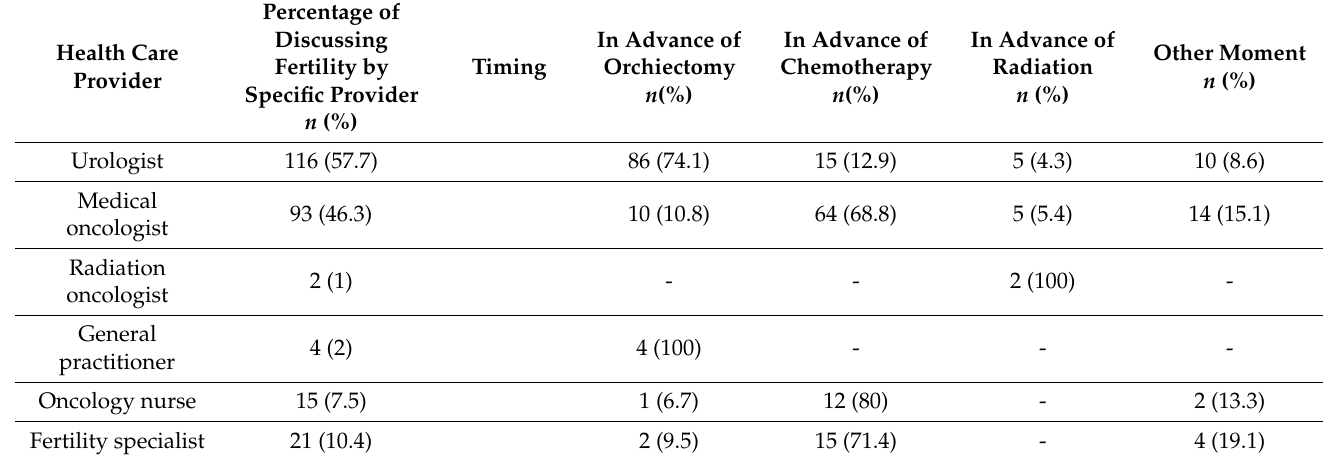
Table 2. Information provision regarding the possible reduced fertility.